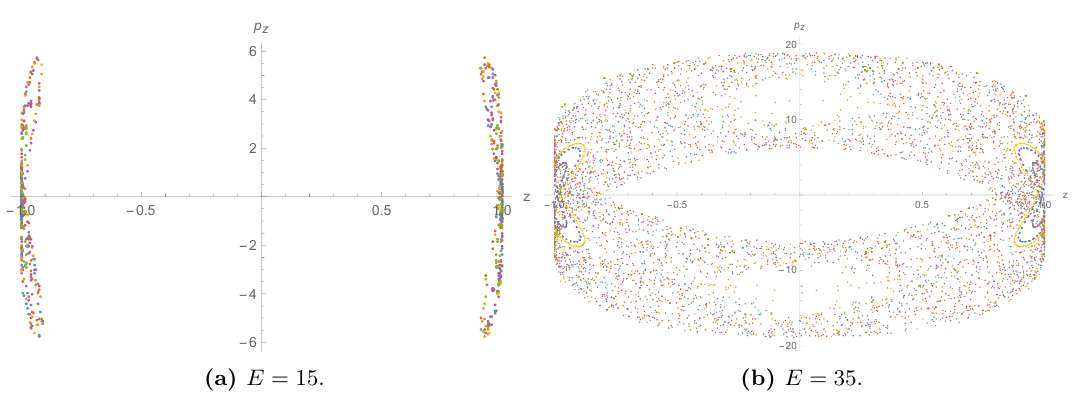
Figure 13. Poincar(cid:19)e sections for the ( (cid:31); p (cid:31) )-plane at z ( t ) = 2, for the quiver in eq. (2.7) at di(cid:11)erent energies.